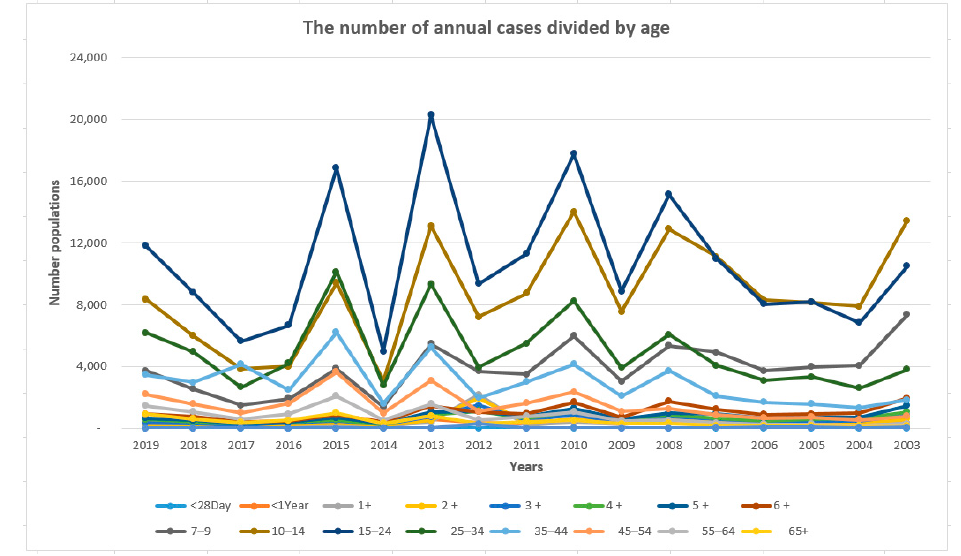
Figure 1. The number of DF patients each year divided into age groups [24].